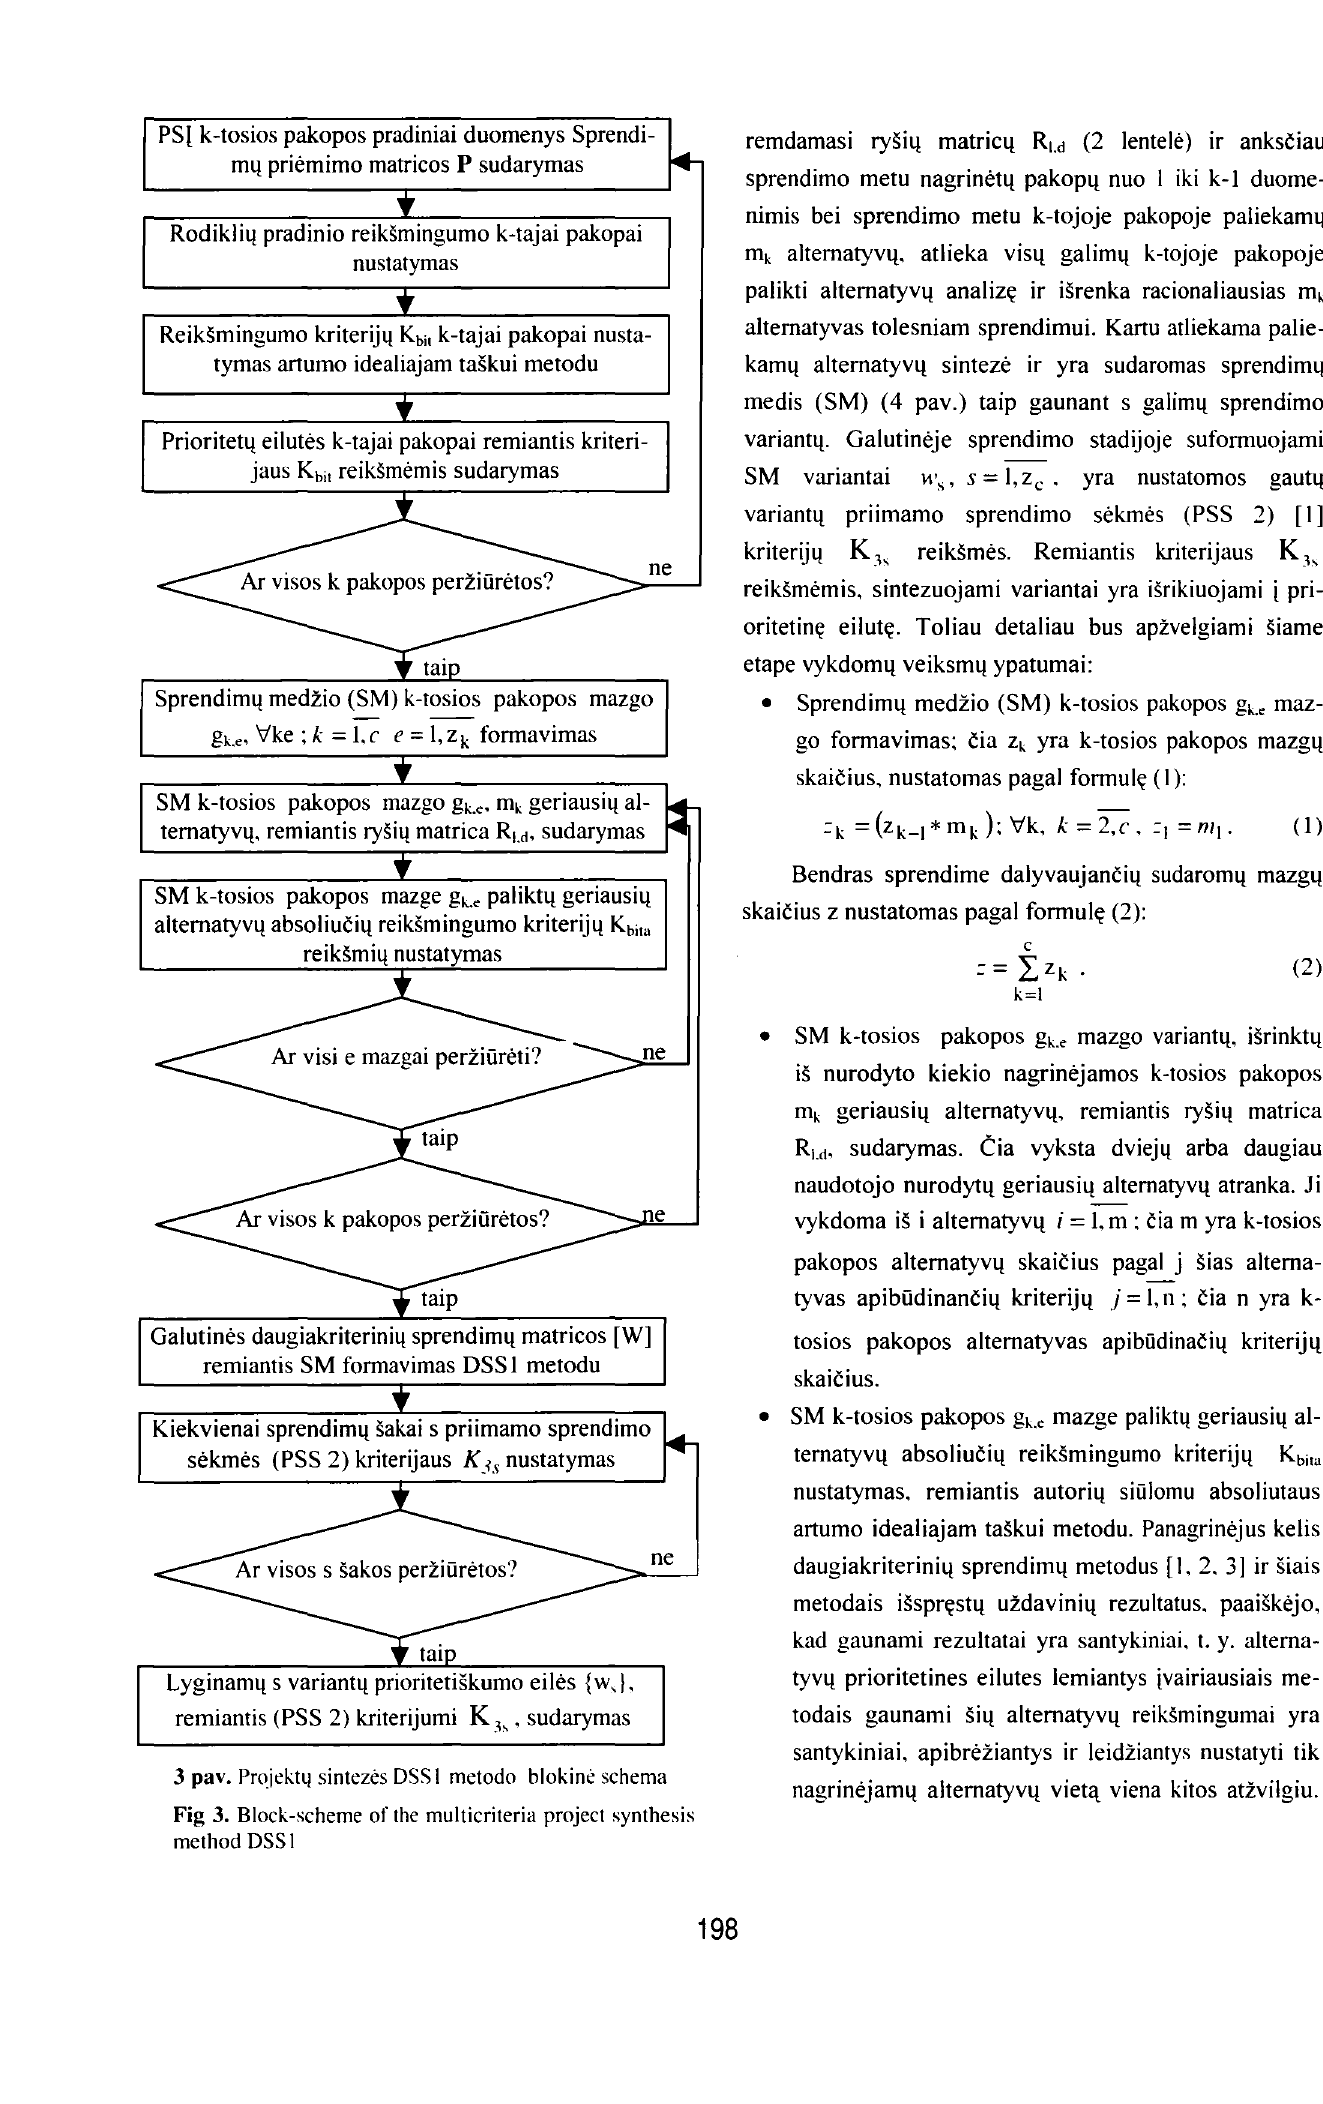
Fig 3. Block-scheme of the multicriteria project synthesis method